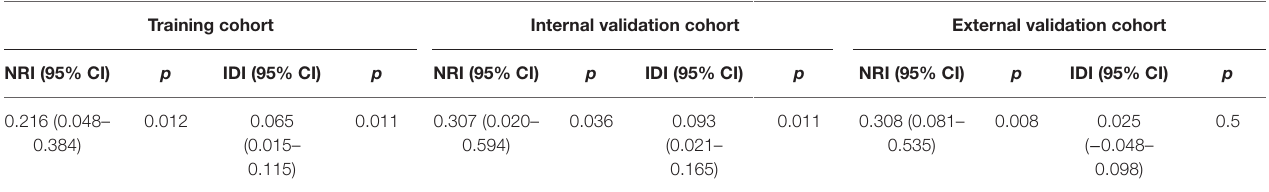
TABLE 5 | The improvement of miRNA-based nomogram in predicting lung metastasis according to net reclassification improvement (NRI) and integrated discrimination improvement (IDI). Training